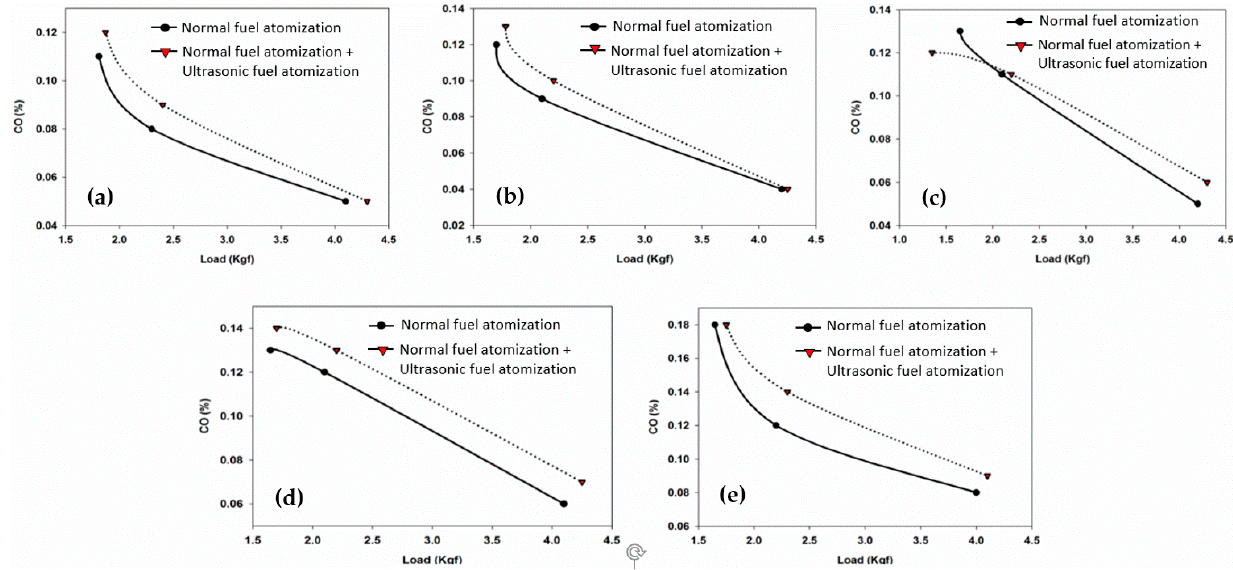
Figure 4. Plots of CO emissions against the engine load for all the different fuel types: ( a ) kerosene, ( b ) B20, ( c ) B50, ( d ) B75 and ( e ) B100.